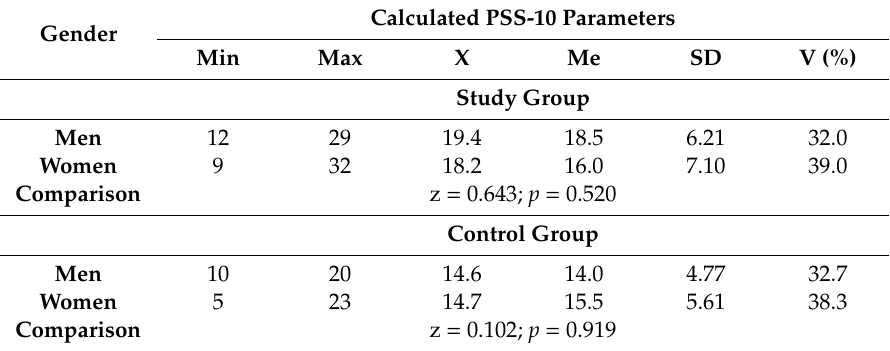
Table 4. Comparison of PSS-10 results in men and women in the study and control groups.